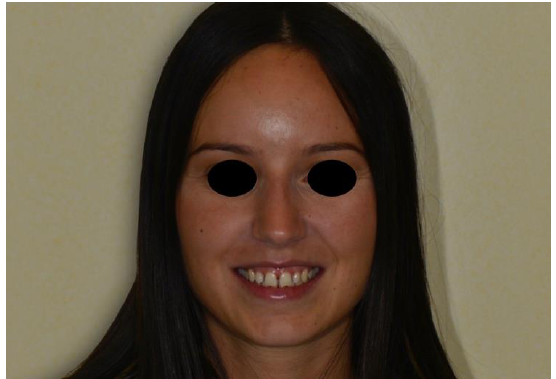
Figure 1. Preoperative full-face view.